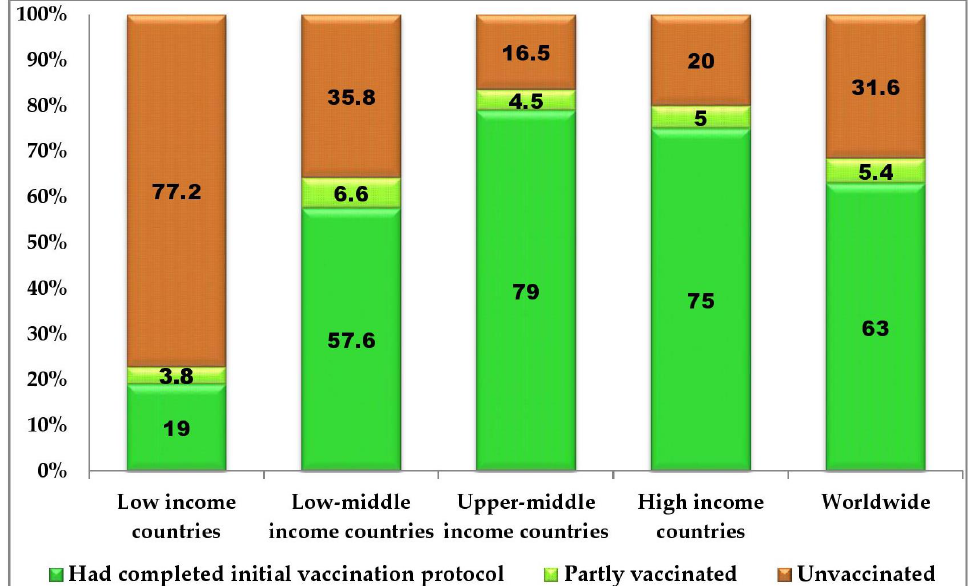
Figure 4. Global distribution of COVID-19 vaccination status according to World Bank’s classification by income levels as of 25 October 2022 (adapted from: https://ourworldindata.org/coronavirus, accessed on 25 October 2022 [13]).